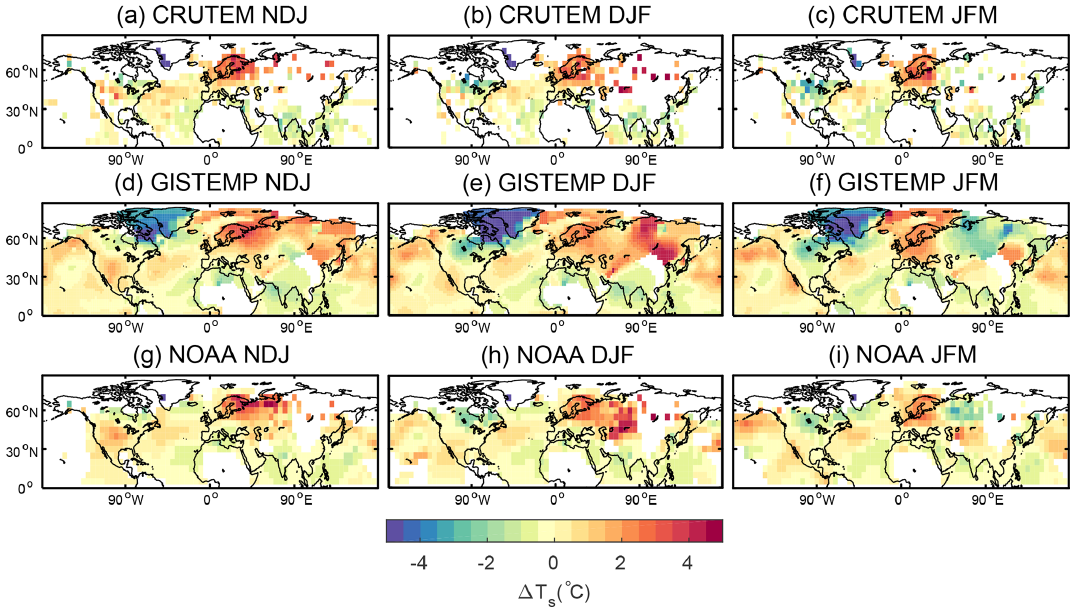
Figure 1. (a–c) CRUTEM post-Krakatau surface temperature anomalies ( (cid:49)T s ) averaged over (a) November to January, (b) December to February, and (c) January to March. Panels (d–f) and panels (g–i) are the same as panels (a–c) but for GISTEMP and NOAA, respectively. Due to data availability, the anomalies panels (d–f) and panels (g–i) are computed using a shorter three-winter reference